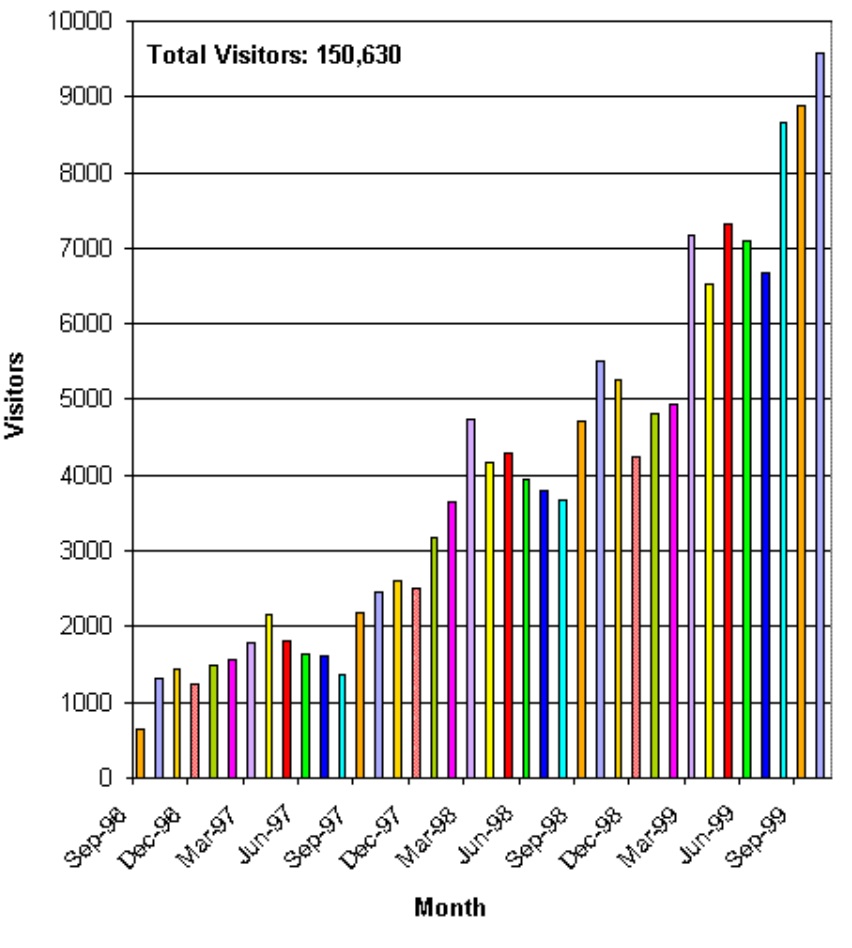
Figure 4. Number of times The Basics of MRI was accessed per month since September